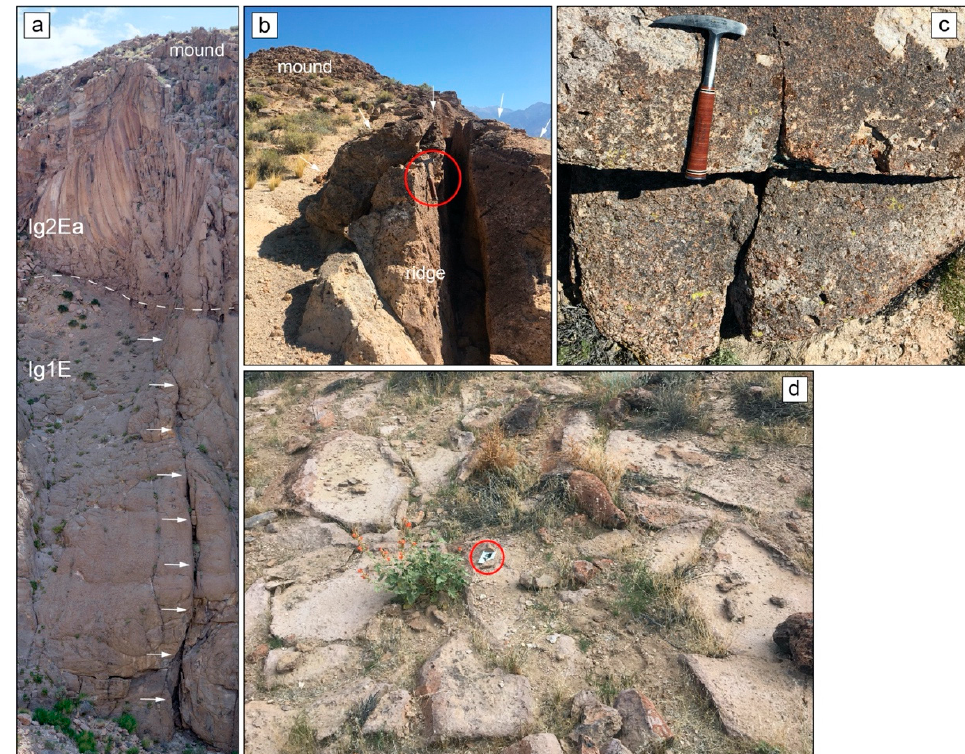
Figure 3. Field expressions of observed joints in the Bishop Tuff. ( a ) Vertically continuous joint functioning as fumarolic pathway (see white arrows) extending ~40 m upwards from the base of Owens River Gorge. Columnar joints are expressed in the vapor-phase altered Ig2Ea tuff that overlies densely welded and devitrified Ig1E. Columnar joints in Ig2Ea radiate outwards from the fumarolic pathway indicating that the joint represented a locus of higher heat flow. The structure is observed beneath a fumarolic mound. ( b ) Fumarolic ridge viewed in cross-section showing its topographic relief, rock hammer on ridge for scale, circled in red. Note the master joint that served as the pathway for escaping fumarolic vapors and condensate, and the rounded relief of the ridge (white arrows). ( c ) Typical cooling joints with no alteration found along the fracture walls. The continuity of these structures is a function of the degree of welding, with higher degrees of welding promoting a greater vertical continuity. ( d ) Morphology of fumarolically altered cooling cracks in the vicinity of fumarolic mounds. Their polygonal shapes and small sizes indicate that fumarolic vapors and condensate leaked diffusely through the rock mass in the vicinity of the fumarole. Scale is circled in red.